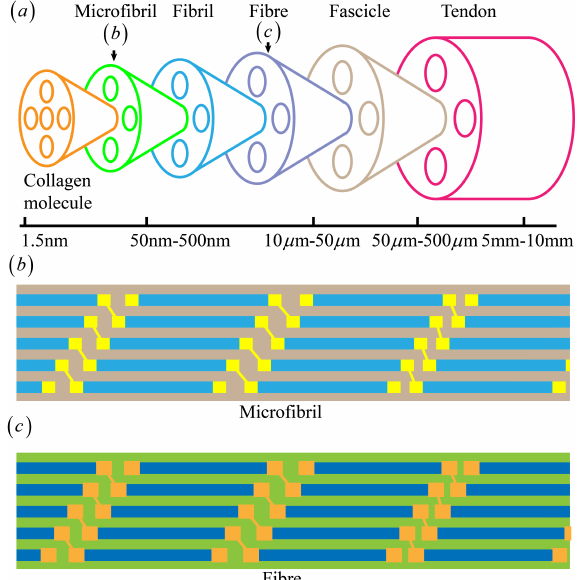
Figure 1. Self-similar structure in tendon. ( a ) Multilevel structure of tendon; ( b ) Arrangement of microfiber; ( c ) Arrangement of